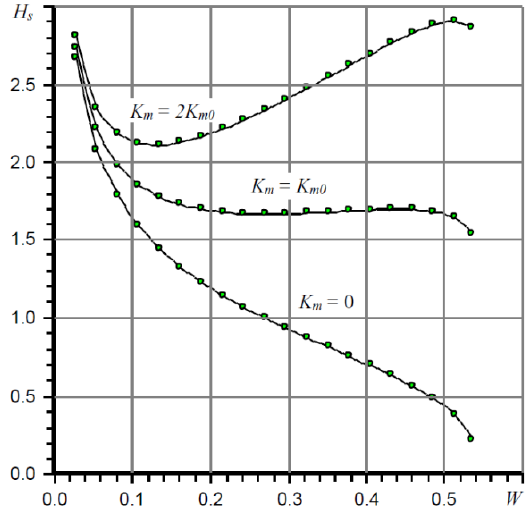
Figure 5. Bearing load characteristics, χ = 0.65, R 1 = 0.5